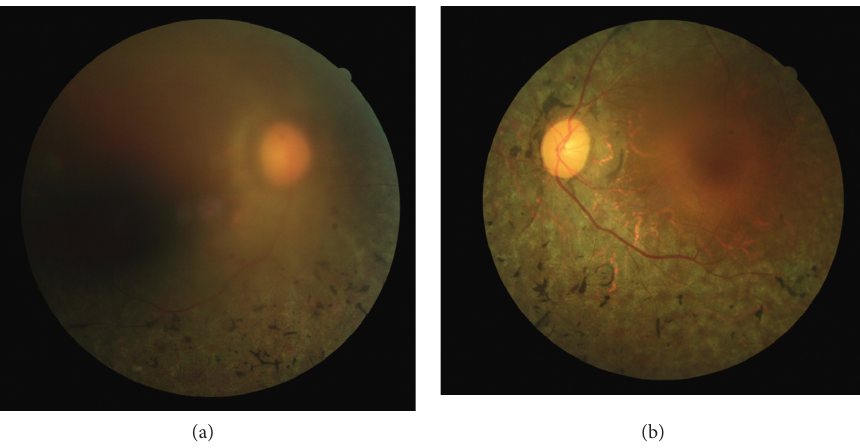
Figure 1: Example of a patient with unilateral retinitis pigmentosa. (a) The right eye showed blurred fundus due to cataract. (b) The left eye showed a typical fundus picture of a RP patient, including bone spicules, attenuated vessels, and waxy pallor of the optic